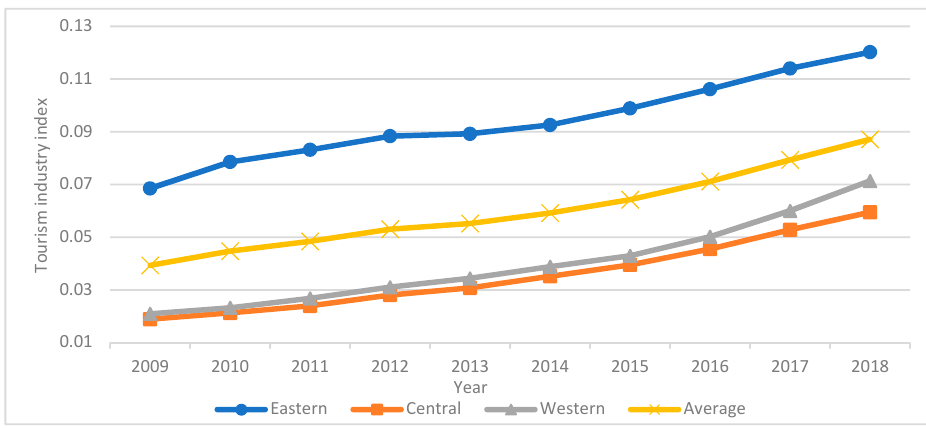
Figure 2. Changes in the tourism industry index in the eastern, central and western regions over time.